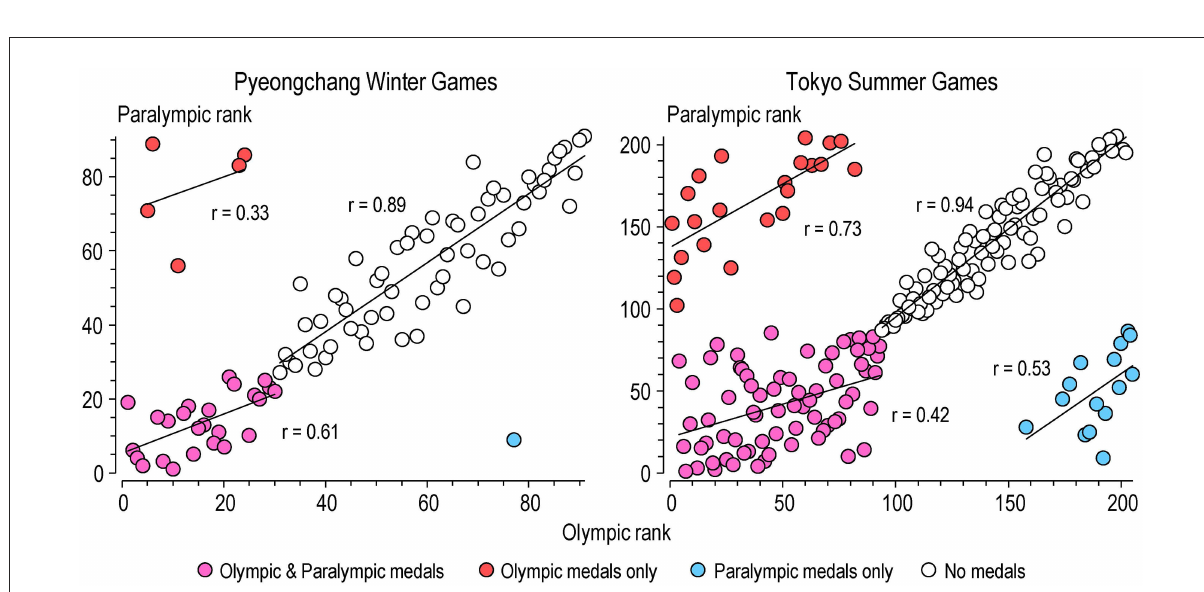
FIGURE3 Relationships between Olympic and Paralympic medal ranks of nations that attended the Pyeongchang winter games and the Tokyo summer games. Regression lines and correlations are shown for nations grouped according to whether or not they won medals at the Olympics and